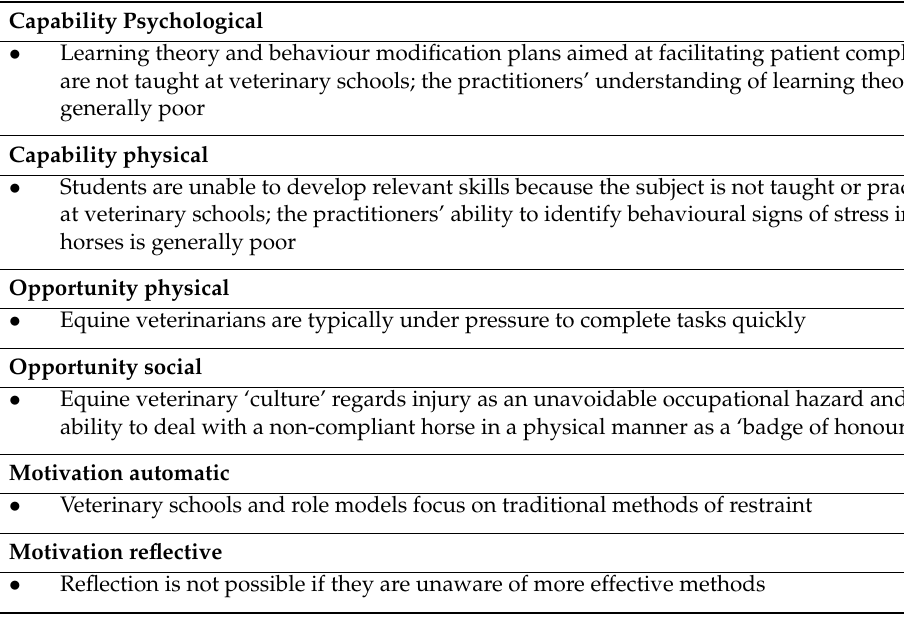
Table 2. Summary of barriers to performance of target behaviour (veterinary students’ use of learning theory to retrain non-compliant